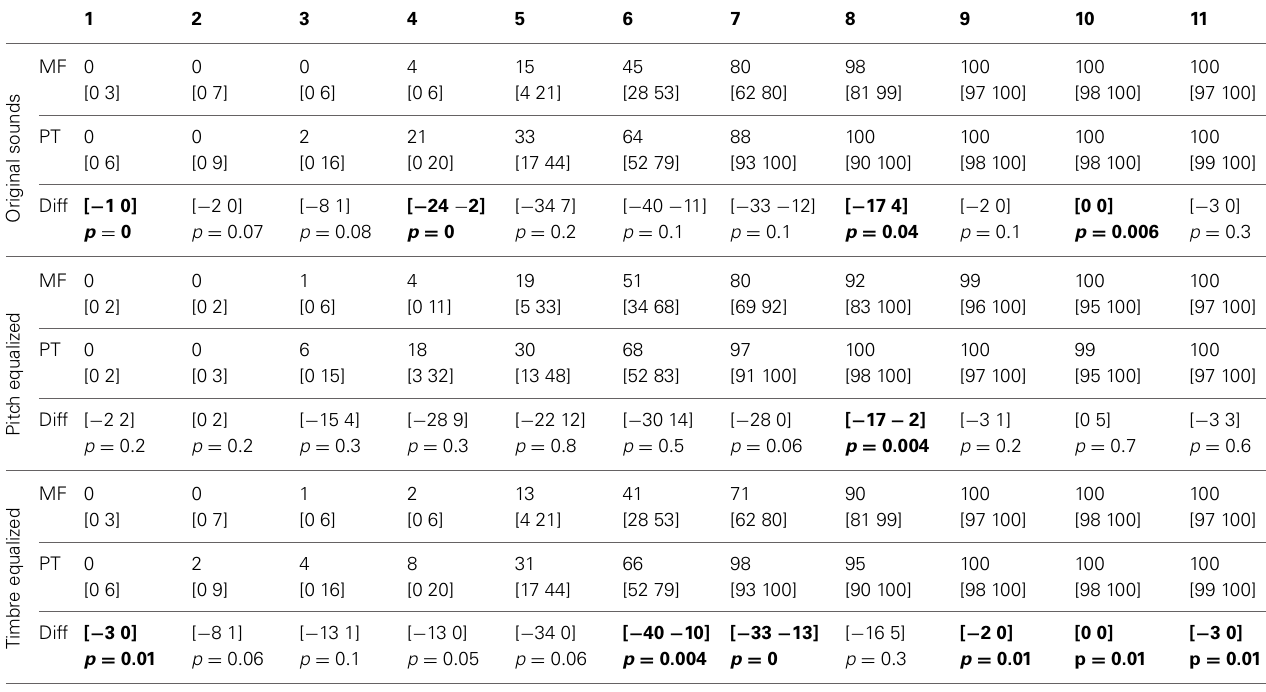
Table 2 | Trimmed mean percentages and 95% CI of “female” or “ta” responses for each task and condition, and 95% CI and p -values of differences between